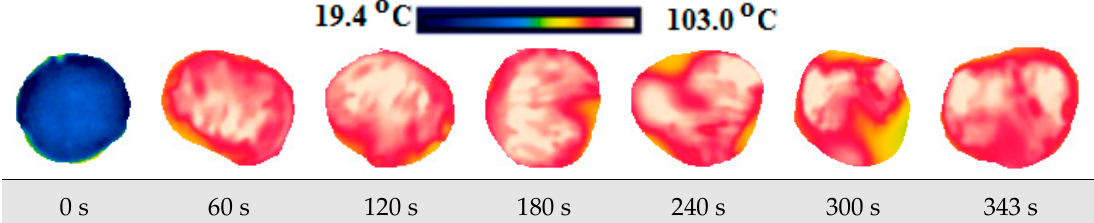
Figure 21. Thermal Figure 21. Thermal images Figure 21. Thermal images Figure 21. Thermal images